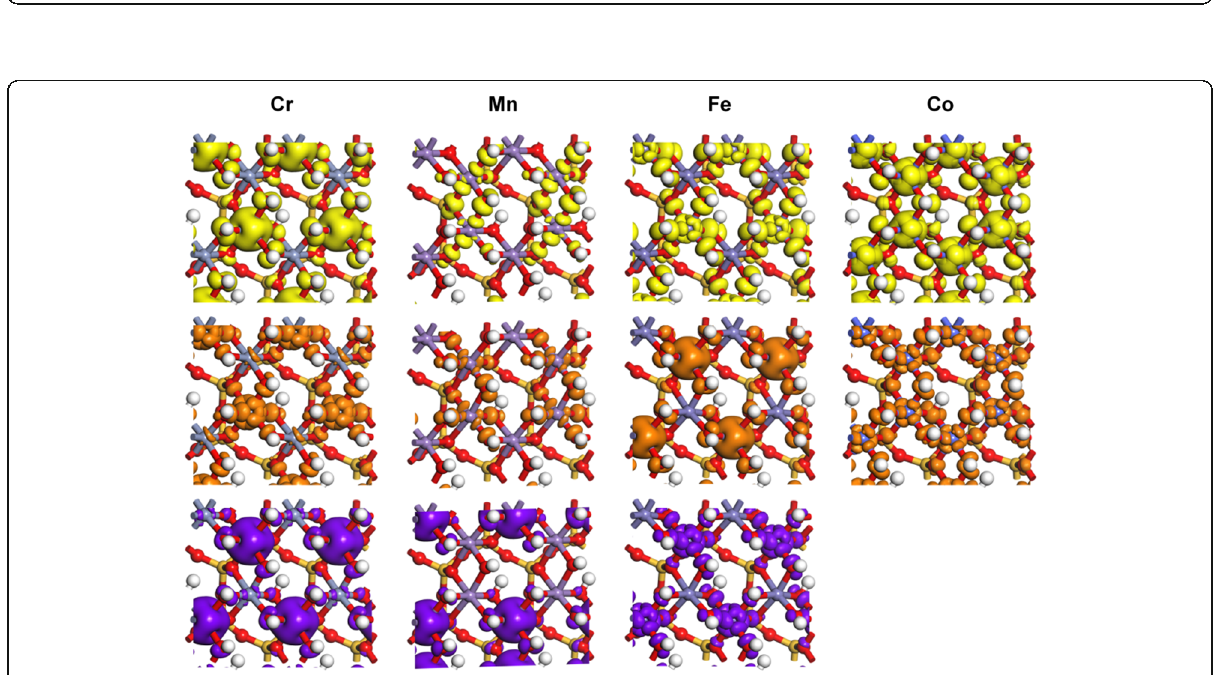
Fig. 4 Partial charge density of TM 3d orbitals in TM – kaolinite, corresponding to the states pointed by arrows in PDOS results. The isosurface levels are 0.02 e/Å